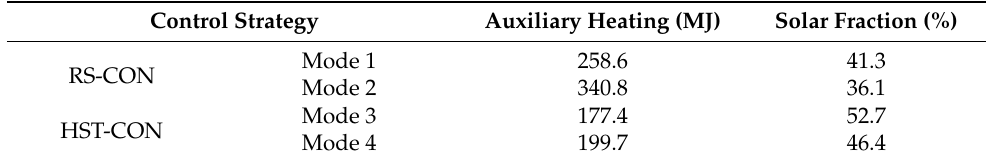
Table 1. Auxiliary heating and solar fraction under different control strategies.